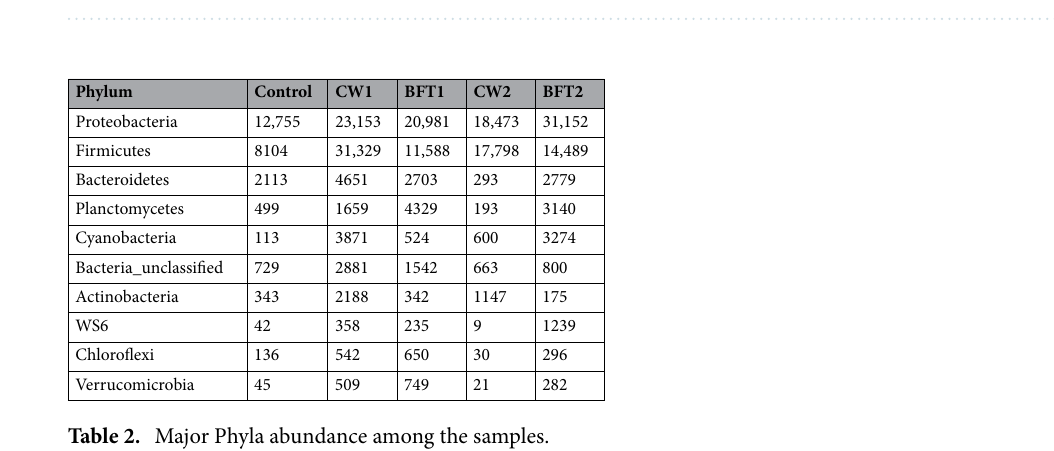
Table 1. Water quality parameters observed in different treatments (mean ± SE (n)). Means in the same row having different superscript a,b,c,d differ significantly. *P < 0.05; Means in the same row having same superscript are not significant.